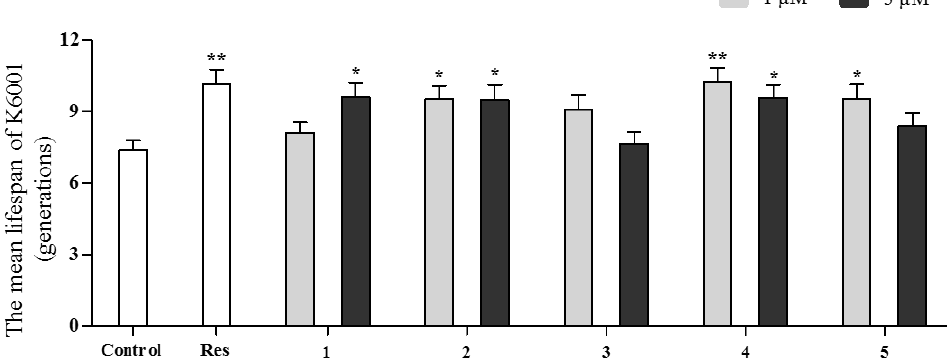
Figure 4. Effect of allomicrophyllone ( 1 ), ehretiquinone ( 2 ) and ehretiquinones B – D ( 3 – 5 ) on the